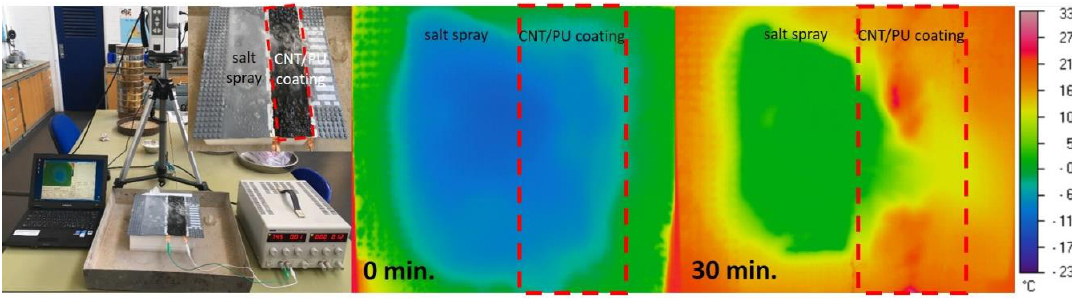
Figure 6. Heat evolution of a 7.0 wt.% CNT/PU coating at 75 V.